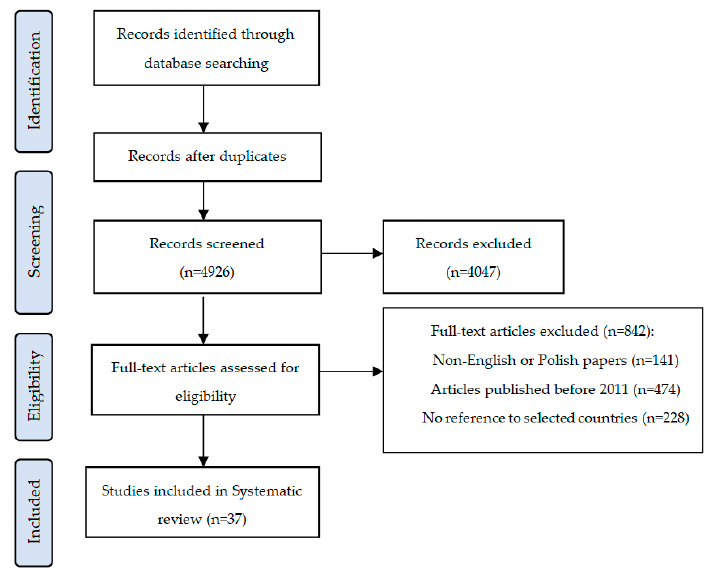
Figure 3. Literature selection diagram (to PRISMA).